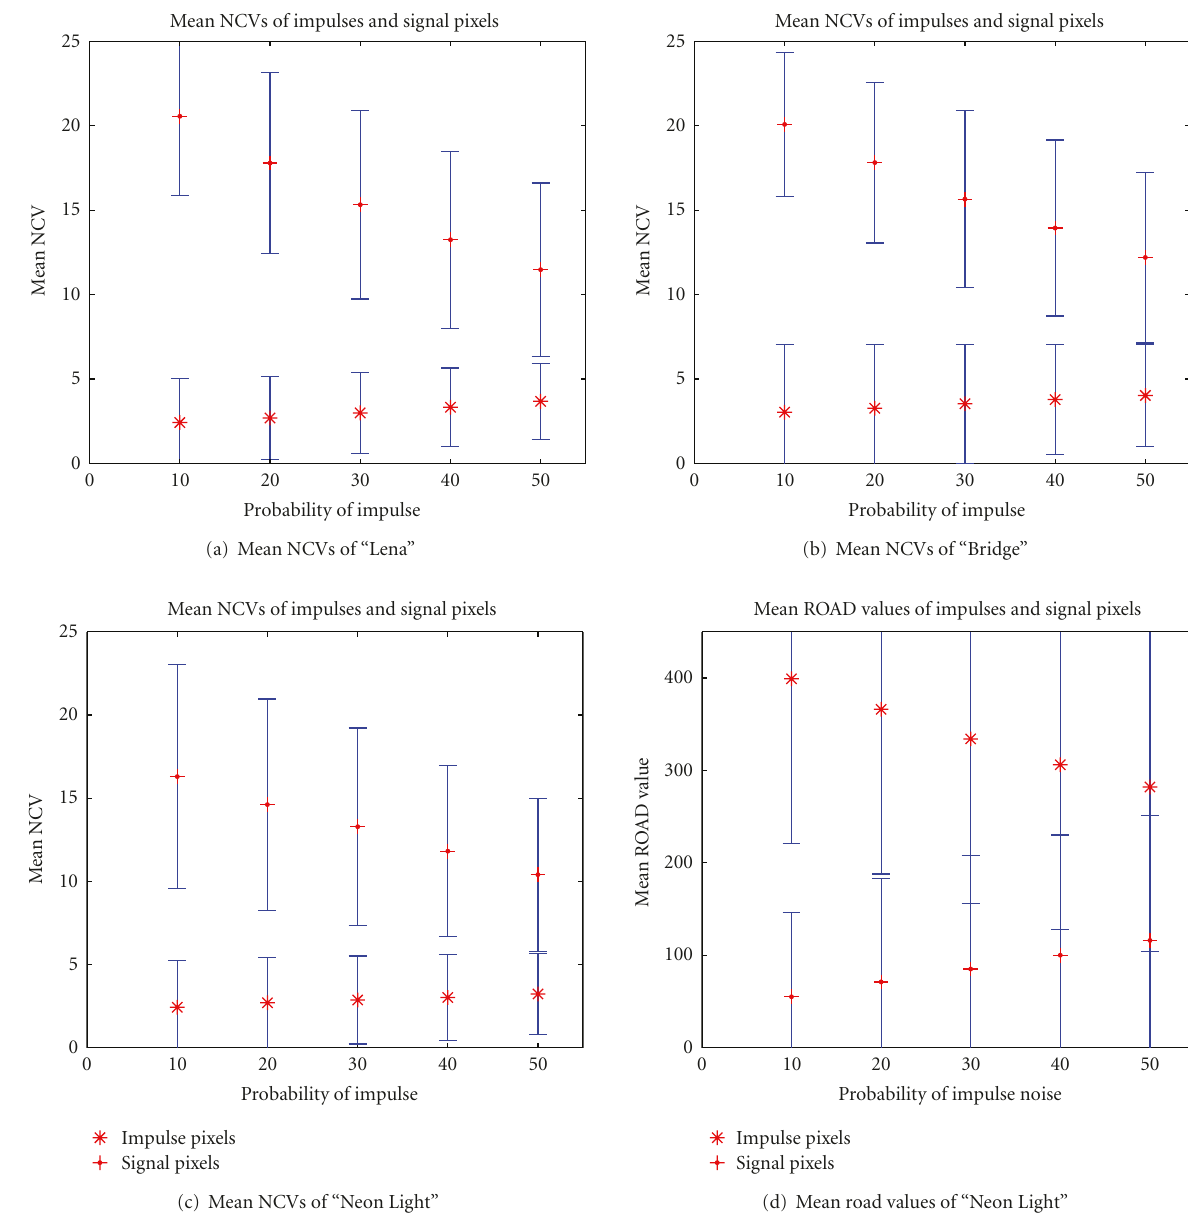
Figure 5: The mean NCV as a function of the impulse noise probability of signal pixels (cross points) and impulse pixels (star points) in the (a) “Lena” image, (b) “Bridge” image, and (c) “Neon Light” image, with standard deviation error bars indicating the significance of the di ff erence; (d) the mean ROAD values of impulse pixels (star points) and signal pixels (cross points) with standard deviation error bars.